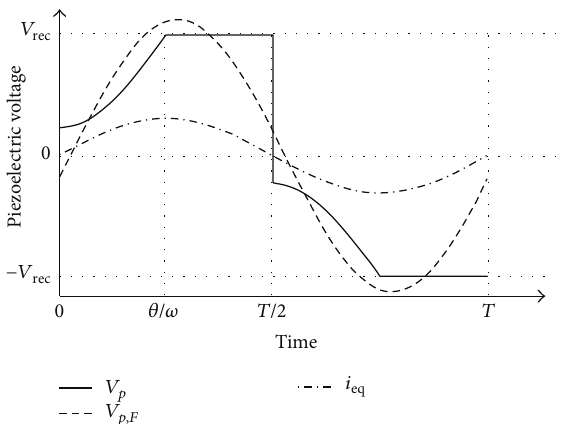
Figure 7: Characteristic voltage and current waveforms of the parallel SSHI circuit.